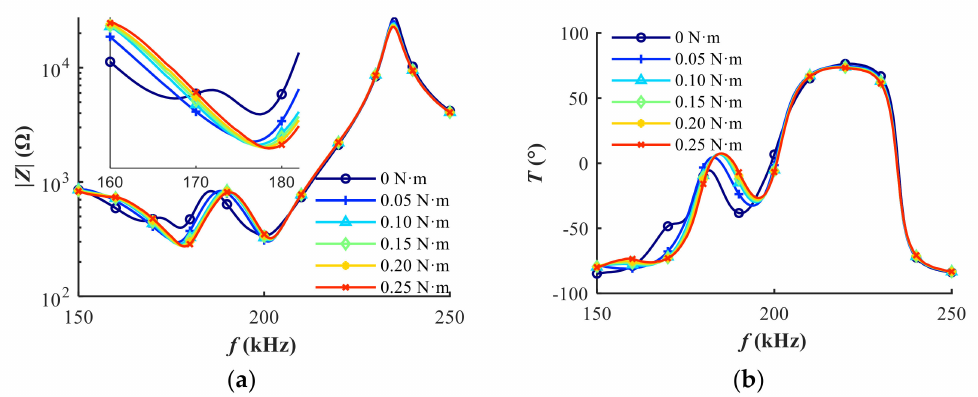
Figure 9. The e ff ect of pre-tightening force on the electrical impedance characteristic: ( a ) magnitude; ( b ) phase.